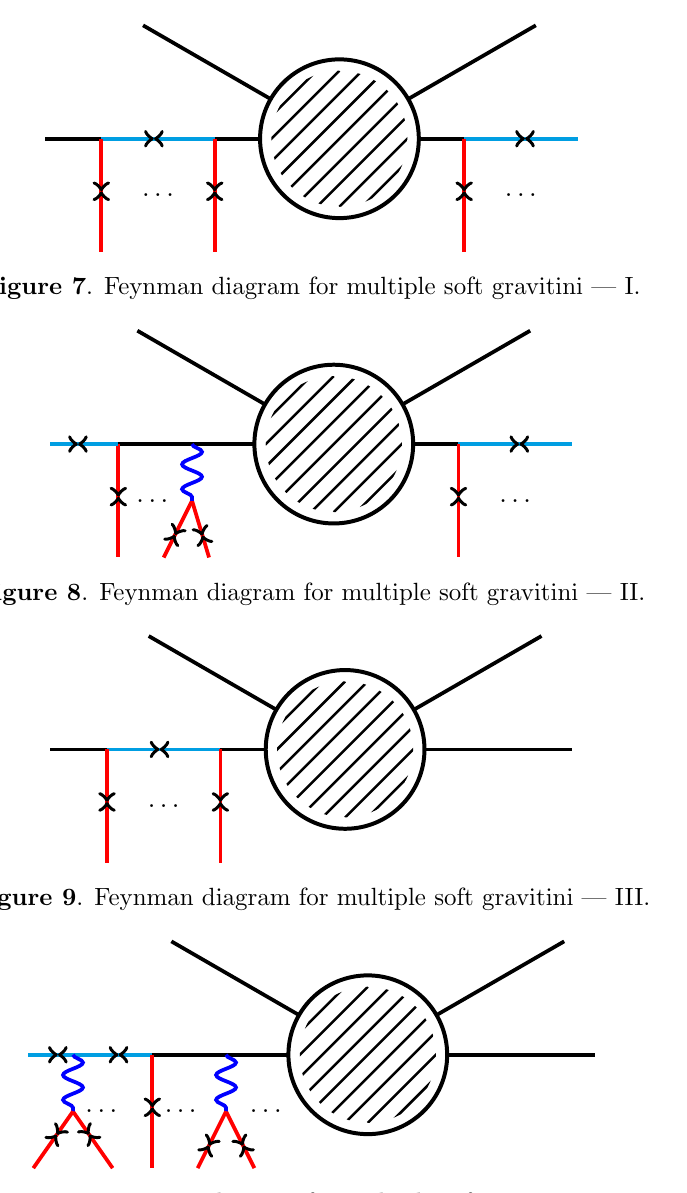
Figure 10 . Feynman diagram for multiple soft gravitini |